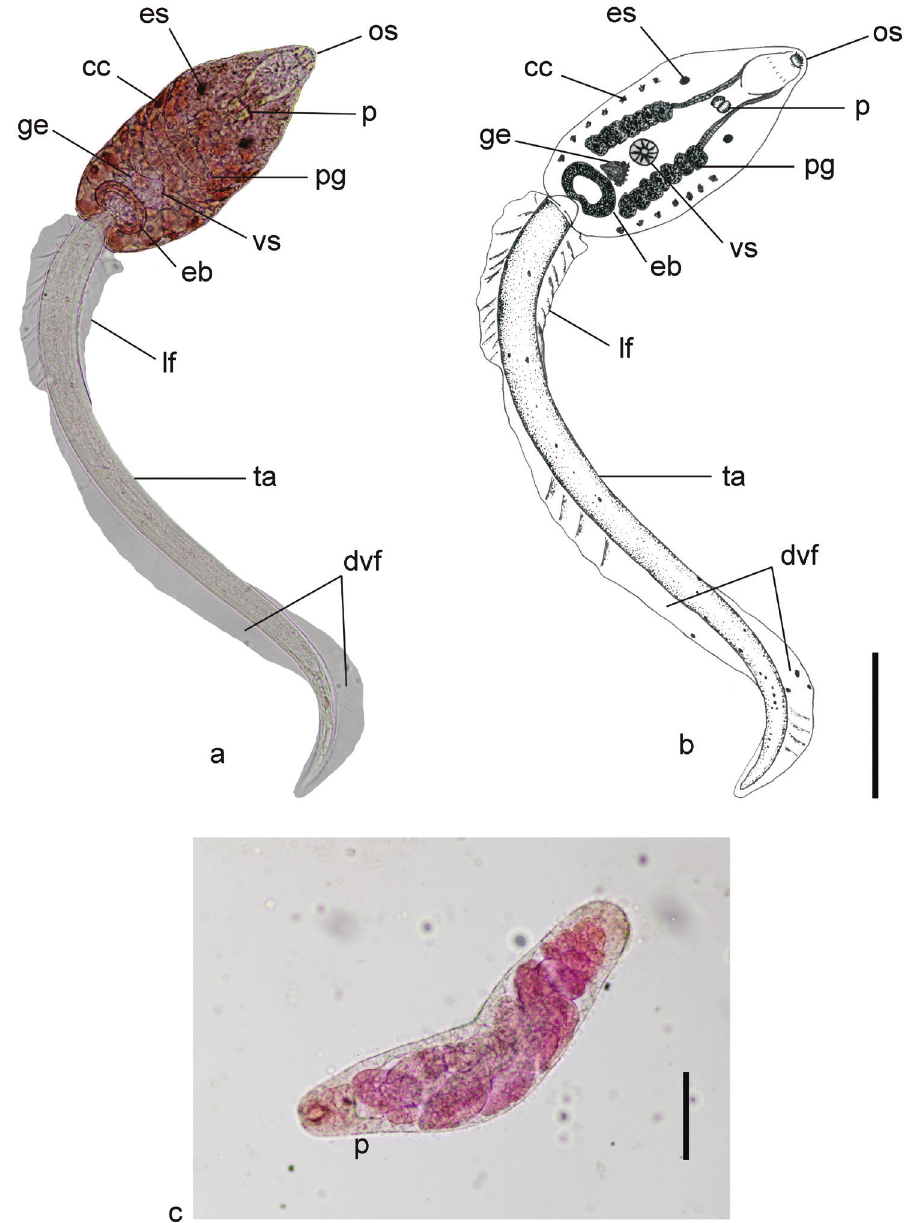
Figure 9. Haplorchis taichui (Nishigori, 1924). a . specimen stained with 0.5% neutral red. b . drawing of cercaria. c . redia stained with 0.5% neutral red. Abbreviations – cc: cystogenous cells; dvf: dorsoventral finfold; eb: excretory bladder; es: eyespot; ge: gen - ital primordium; lf: lateral finfold; os: oral sucker; p: pharynx; pg: penetration gland; ta: tail; vs: ventral sucker. Scale bars: 50